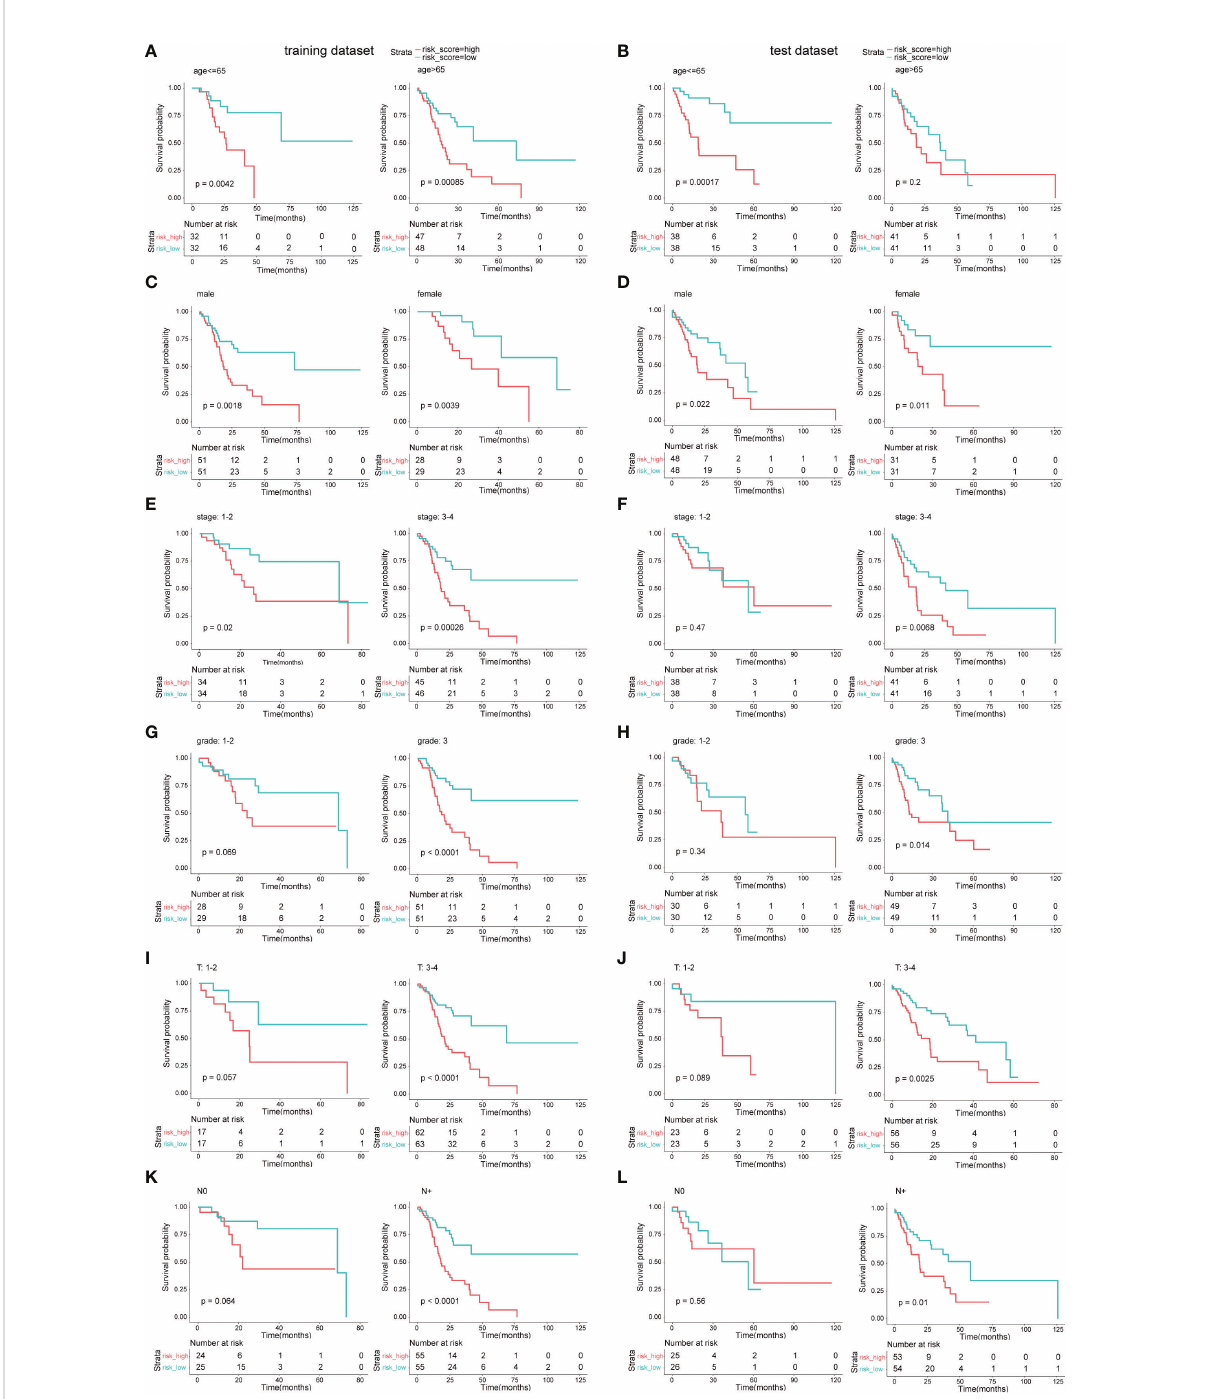
FIGURE 5 Survival analysis in different clinical feature cohorts. (A, C, E, G, I, K) OS comparison between the low-risk subgroup and the high-risk subgroup in different cohorts of the training dataset. (B, D, F, H, J, L) OS comparison between the low-risk subgroup and the high-risk subgroup in different cohorts of the test